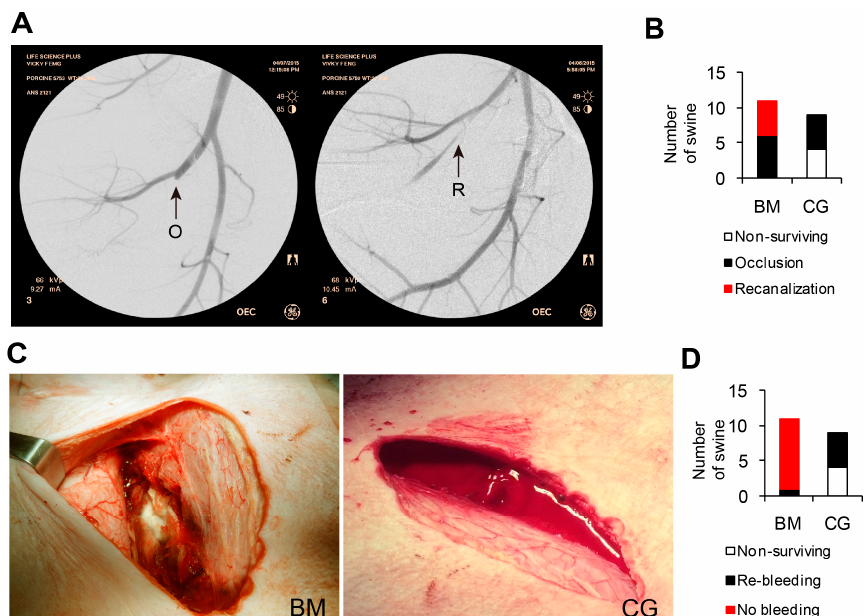
Figure 2. Angiogram of surviving animals and Morphological assessment after removal of tested materials. The femoral artery was occluded at the injury site in 100% of animals treated with CG (5/5) and in 54.5% of animals treated with BM (6/11). In 45.5% (5/11) of animals treated with BM, the artery was narrowed at the injury site but blood was present in the distal femoral artery. Video angiogram analysis demonstrated anterograde flow (not retrograde from collateral circulation). After CG removal, 100% of hemostatic clots ruptured and re-bleeding occurred. In contrast, 90.9% of injuries treated with BM demonstrated stable hemostatic clots with sticky gels over the arterial injury site. ( A ) Representative images from fluoroscopic angiography. The arrow indicates the artery injury site. O: occlusion; R: recanalization; ( B ) Number of animals with injured artery recanalization or occlusion; ( C ) Representative images of injury site after product removal; ( D ) Number of animals with or without re-bleeding after product removal.